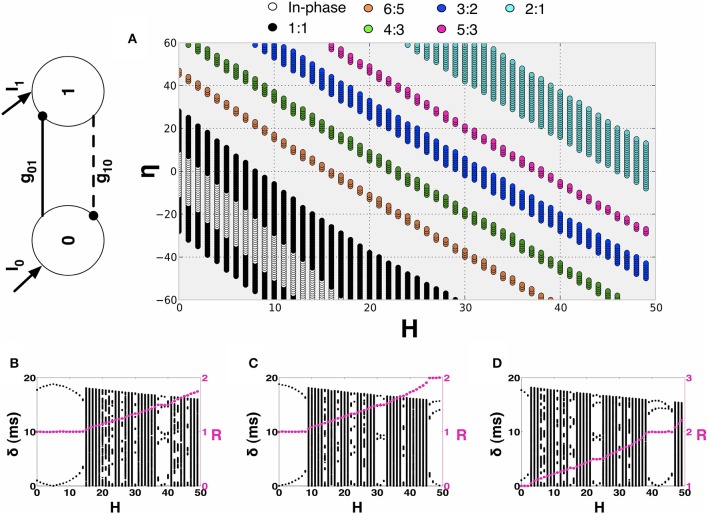
Synchronization manifold of the 2-MCI network. (A) Synchronization manifold of the 2-MCI network (shown in inset). The Figure shows the domain of m:n synchronization for the 2-MCI network in the two dimensional plane spanned by the network heterogeneity parameter H, and the network imbalance parameter η. In (B–D), we plot the time lag δ between the firing times of the two neurons in the 2-MCI network as function of the network temporal heterogeneity parameter H for three different cases of the network temporal heterogeneity parameter η = {−20, 0, 20}, respectively. In each Figure, we also plot the ratio of mean firing periods of the two neurons R (magenta dots).